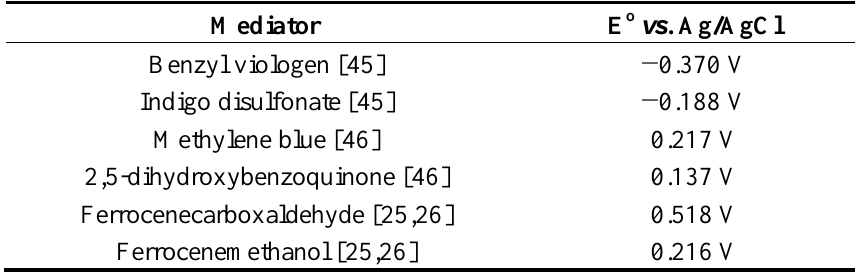
Table 1. Examples of redox mediators used with electrochemical sensors that incorporate Glucose